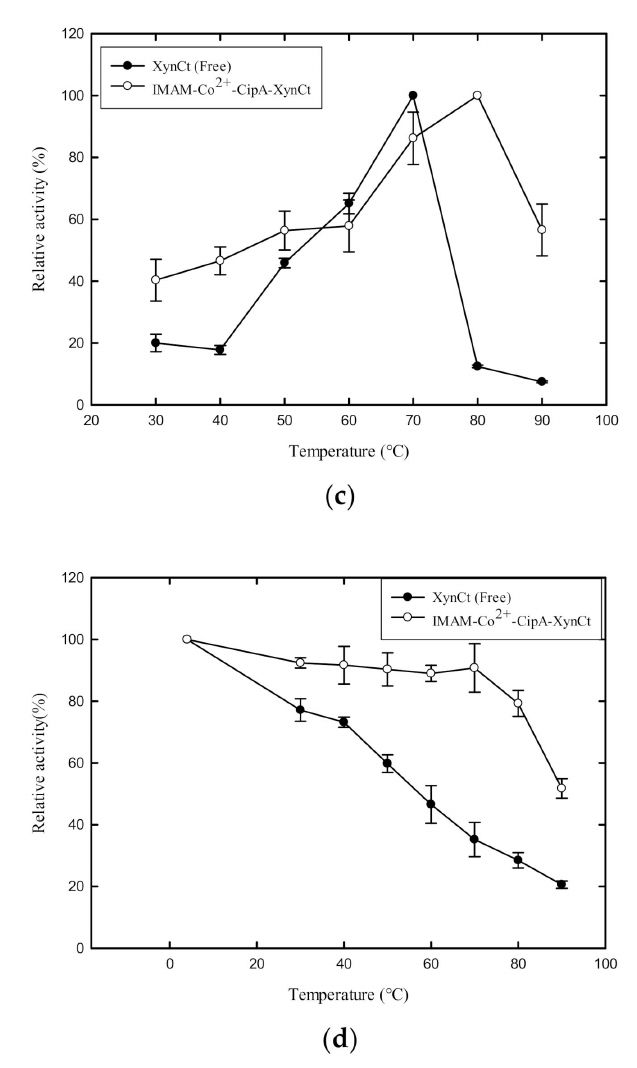
Figure 5. The e ff ects of pH and temperature on IMAM-Co 2 + -CipA-XynCt and free XynCt. ( a ) The enzyme activities in the range from pH 4 to 9 in Britton–Robinson bu ff er and 60 ◦ C. ( b ) Relative enzyme activity in storage condition at the pH in the range from pH 4 to 9 (4 ◦ C in Britton–Robinson bu ff er for 1 h). ( c ) The enzyme activities at the temperature range from 30 to 90 ◦ C. ( d ) Relative enzyme stability for storage after the treatments at di ff erent temperatures ranging from 0 to 90 ◦ C for 1 h. The detailed procedures were referred to in Section 3.6. The error bars represent SD, n =